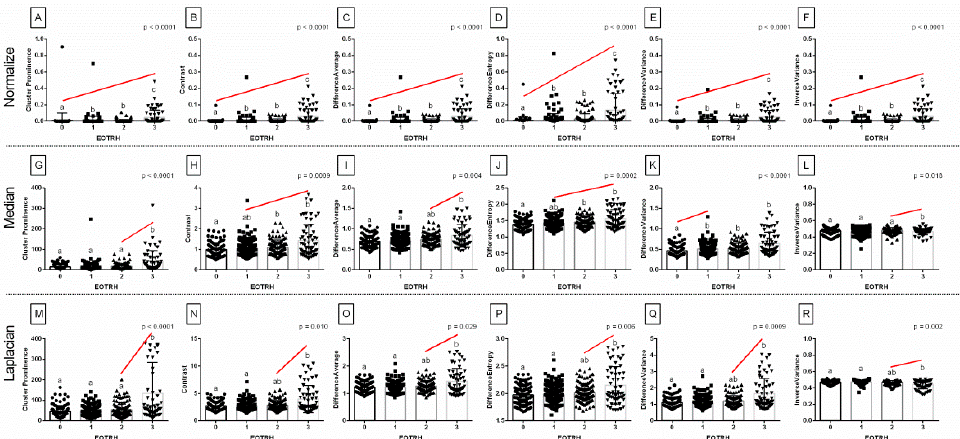
Figure 4. The comparison of the selected Gray–Level Co–occurrence Matrix (GLCM) features between the EOTRH grades (0–3). The following GLCM features are considered: Cluster Prominence ( A , G , M ), Contrast ( B , H , N ), Difference Average ( C , I , O ), Difference Entropy ( D , J , P ), Difference Variance ( E , K , Q ), Inverse Variance ( F , L , R ). The output radiographs filtered by Normalize ( A – F ), Median ( G – L ), and Laplacian Sharpening ( M – R ) filtering algorithms are separated by dashed horizontal lines. Lower case letters (a–c) indicate differences between groups for p < 0.05 independently for each feature. The significant increase with the EOTRH grades is marked with a red line. Single realizations are marked with dots.